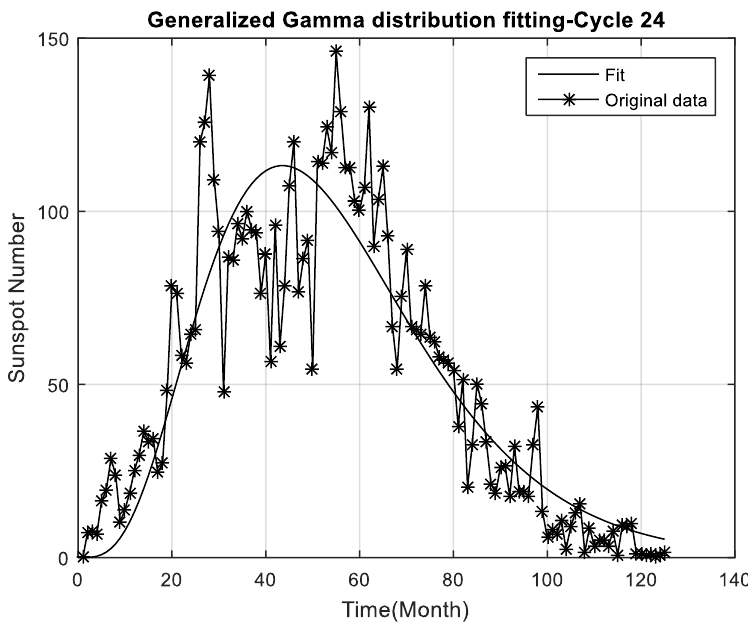
Figure 3. Generalized Gamma distribution fit on the monthly averaged sunspot number cycle